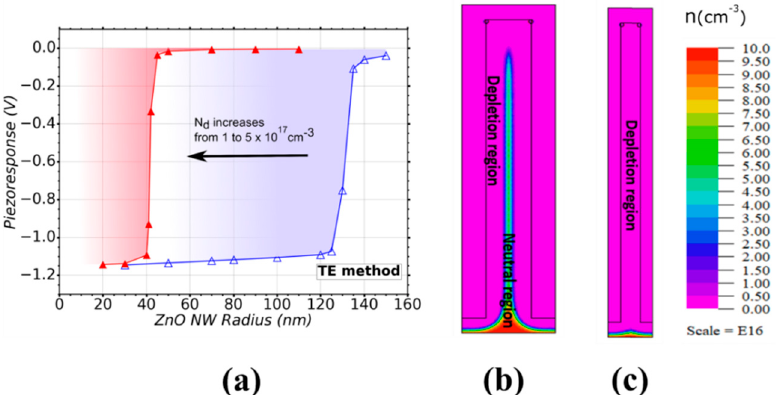
Figure 4. ( a ) Variation of the piezoresponse of a VING as a function of the ZnO NW radius for a range of doping level (N d ) from 1 ( △ ) to 5 ( ▲ ) × 10 17 cm –3 typical in the TE method. The shadowed zones represent the regions of interest for a given doping level. Free carrier distribution of a NW with N d = 1 × 10 17 cm –3 and a radius of ( b ) 140 nm and (c) 80 nm. A trap density N it = 1 × 10 12 eV –1 cm – 2 was considered in the simulation. Table 1. Summary of NW radius values to achieve full depletion or optimal performance for the different growth methods (NW critical radius). In the case of the CBD (O) technique, the values correspond to the radius to obtain half the optimal